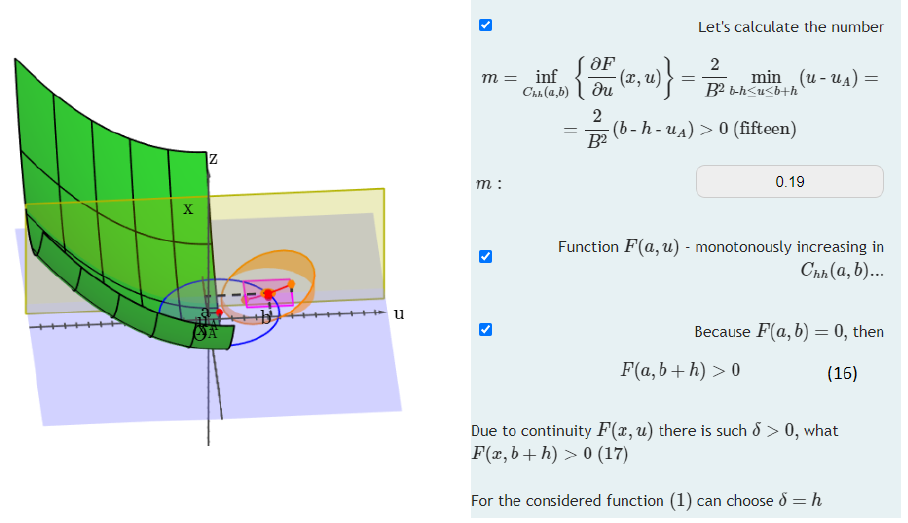
Fig. 3. Visual-geometric proof of the